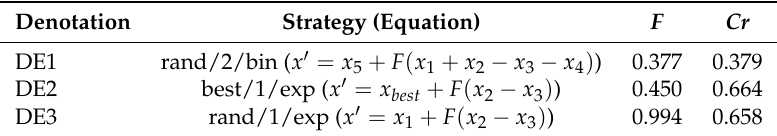
Table 1. Hyperparameters of randomly selected Differential Evolution (DE) variants.